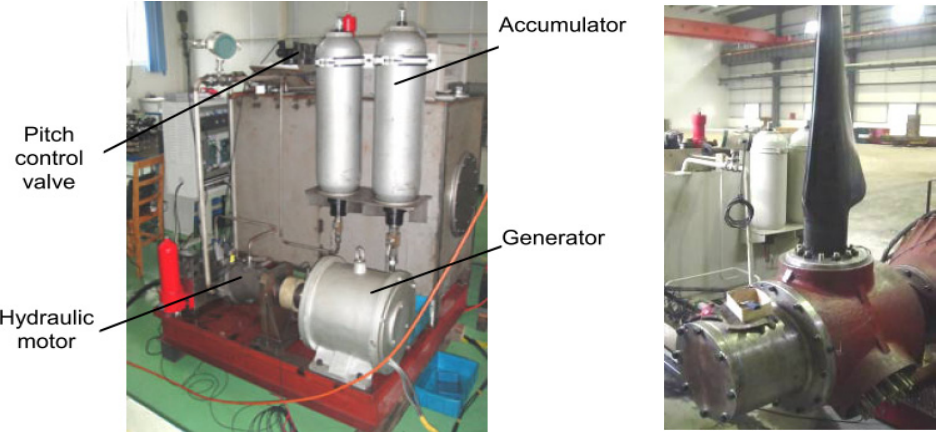
Figure 17. The 20 kW horizontal-axis hydraulic variable-speed variable-pitch TCPGS. Reproduced from [49].